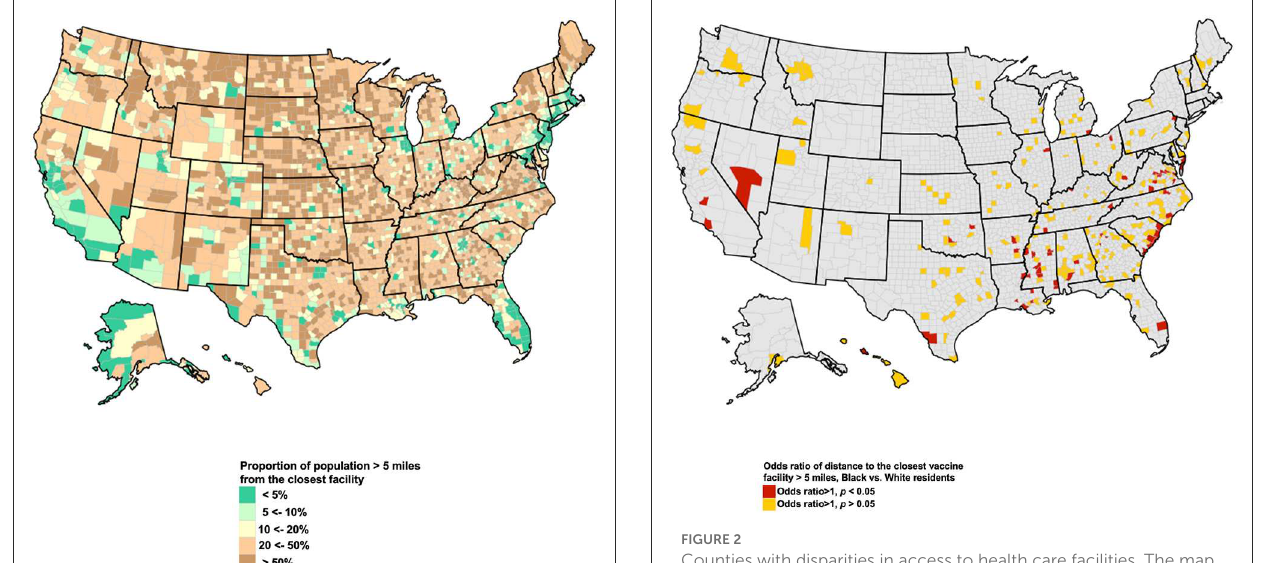
departments from Centers for Medicare and Medicaid Services.